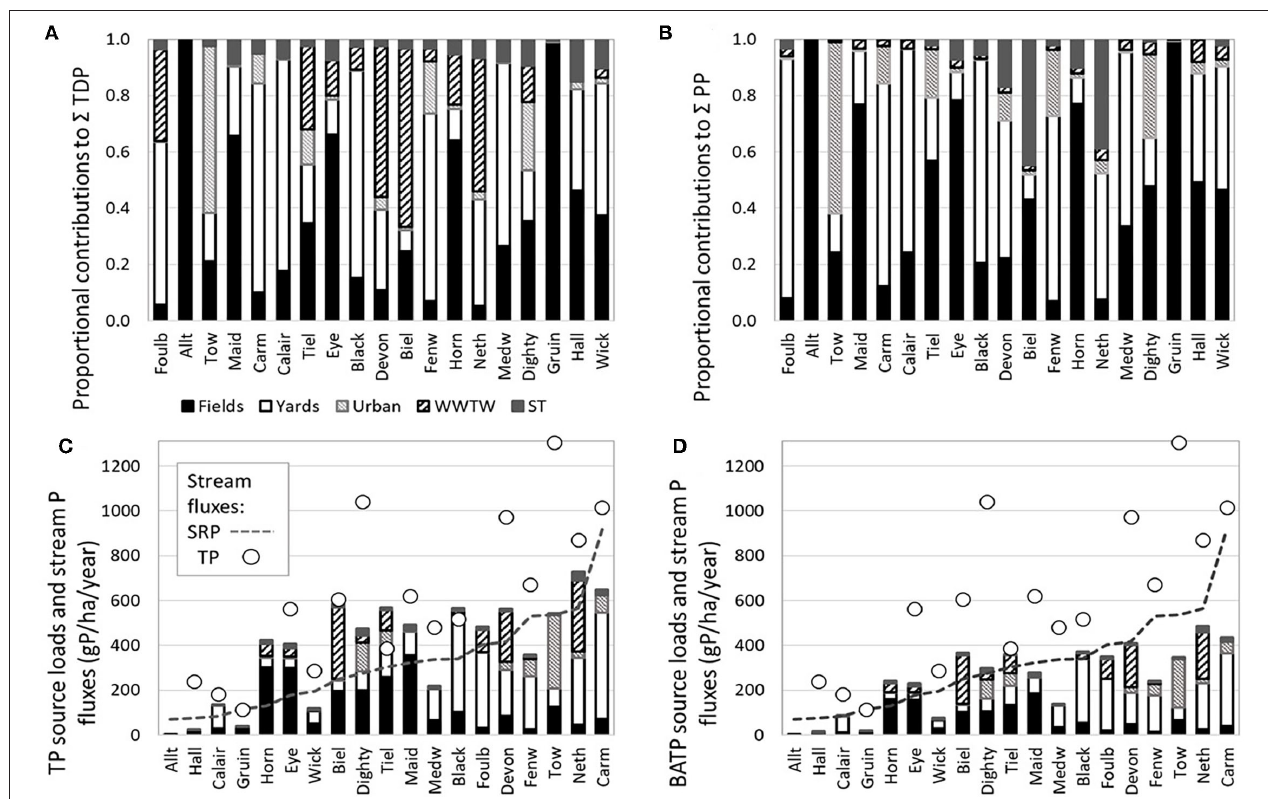
FIGURE 2 | Summary results of the P source estimations and validation against the hydrochemical loads from observed data: Proportional contributions to the sum of (A) total dissolved P (TDP) source loads and (B) particulate P (PP) source loads. Absolute source loads of (C) total P (TP) and (D) bioavailable total P (BATP) are shown against the stream P fluxes (using common y axis). Note the different ordering of sites on the x axis: smallest to largest by catchment size on top row; by stream SRP flux on bottom